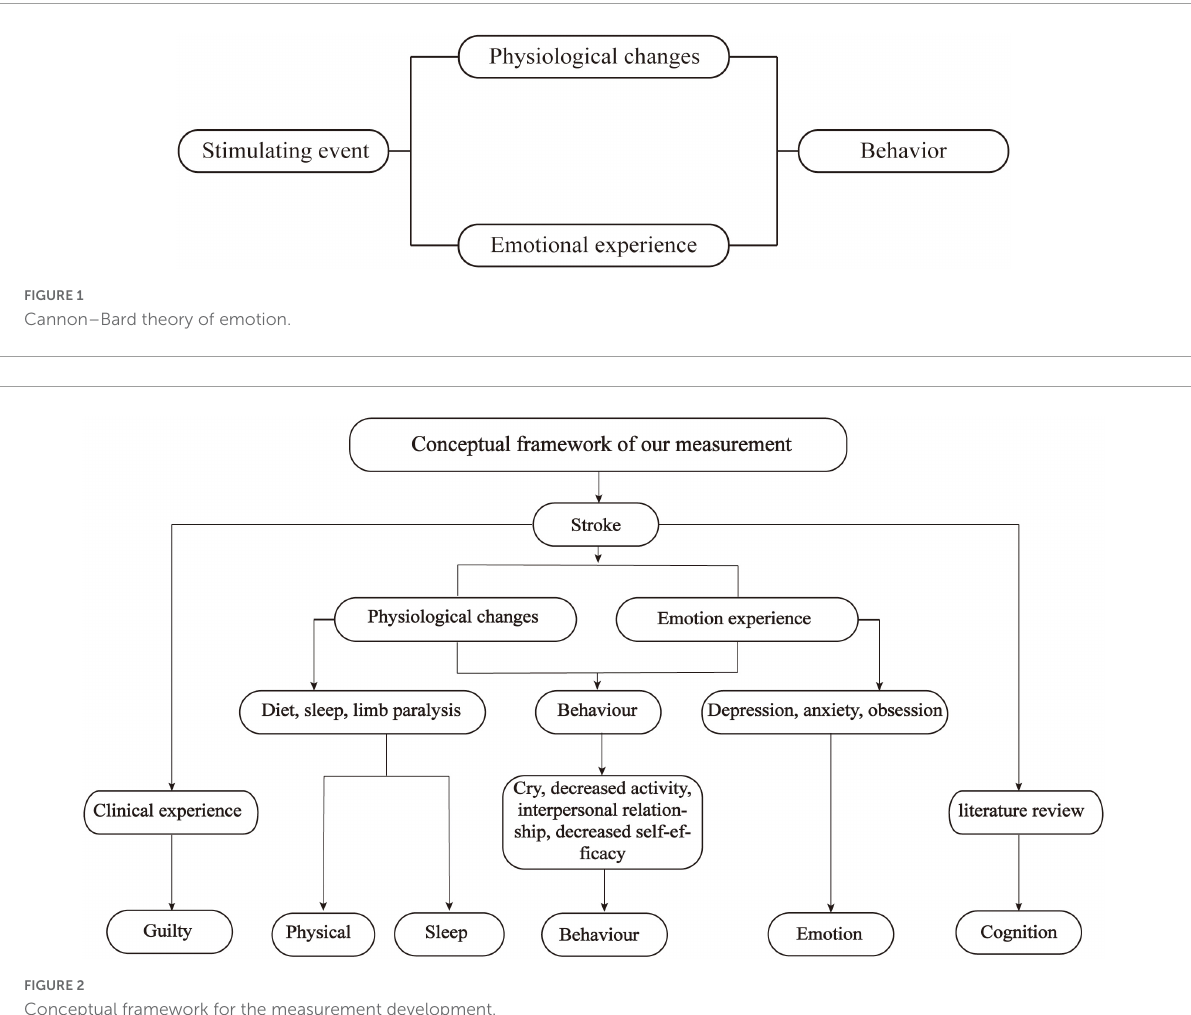
FIGURE2 Conceptual framework for the measurement